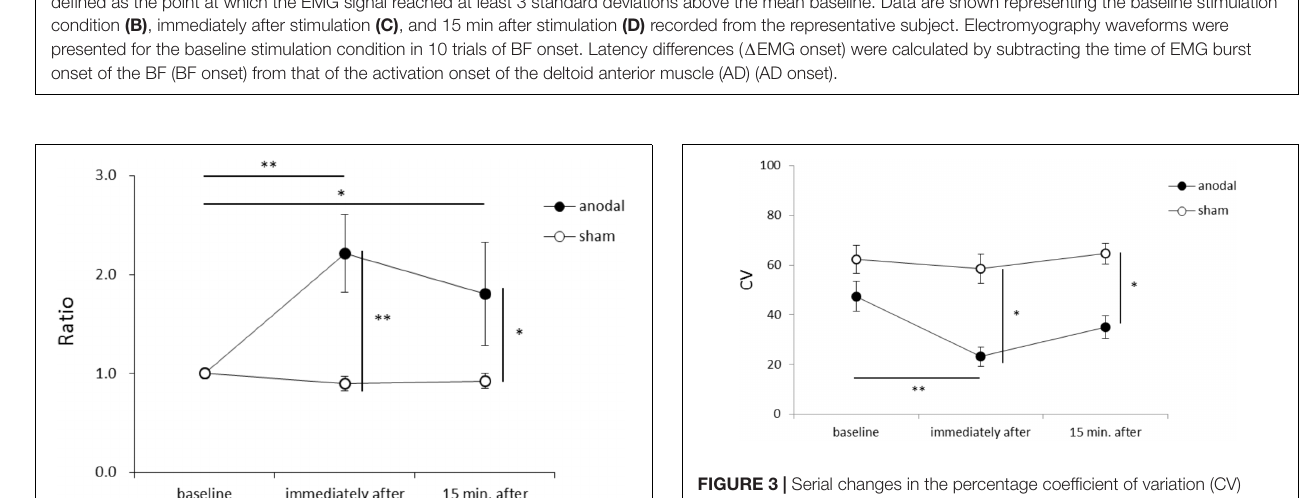
FIGURE 3 | Serial changes in the percentage coefficient of variation (CV) before, immediately after, and 15 min after anodal or sham tDCS over the SMA (mean ± standard error of the mean). ∗ p < 0.05, ∗∗ p < 0.01. COP Recording Subjects stood upright on a force plate (CFP400PA102RS, Leptrino, Japan) with equal weight on each foot and their eyes open. COP visual feedback was provided on a monitor 1.5 m